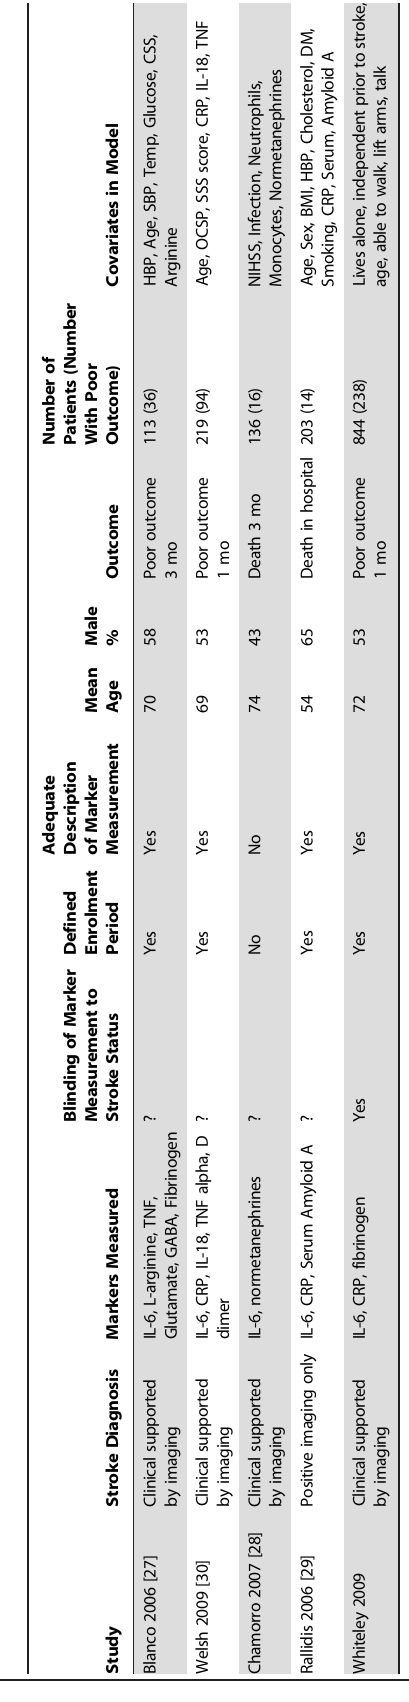
Predicted Risk of Poor Outcome from Six Simple Variable Model with IL-